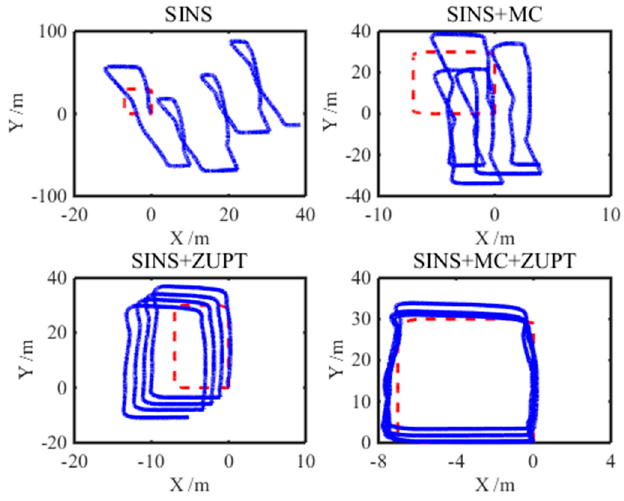
Figure 12. Experimental result of the SINS positioning system for the four-circle trajectory.